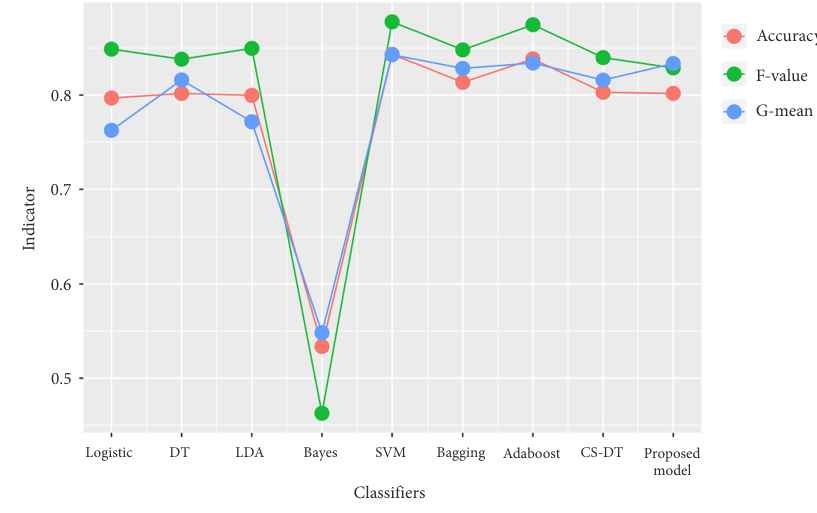
Figure 11. F value, G-mean and accuracy line graph